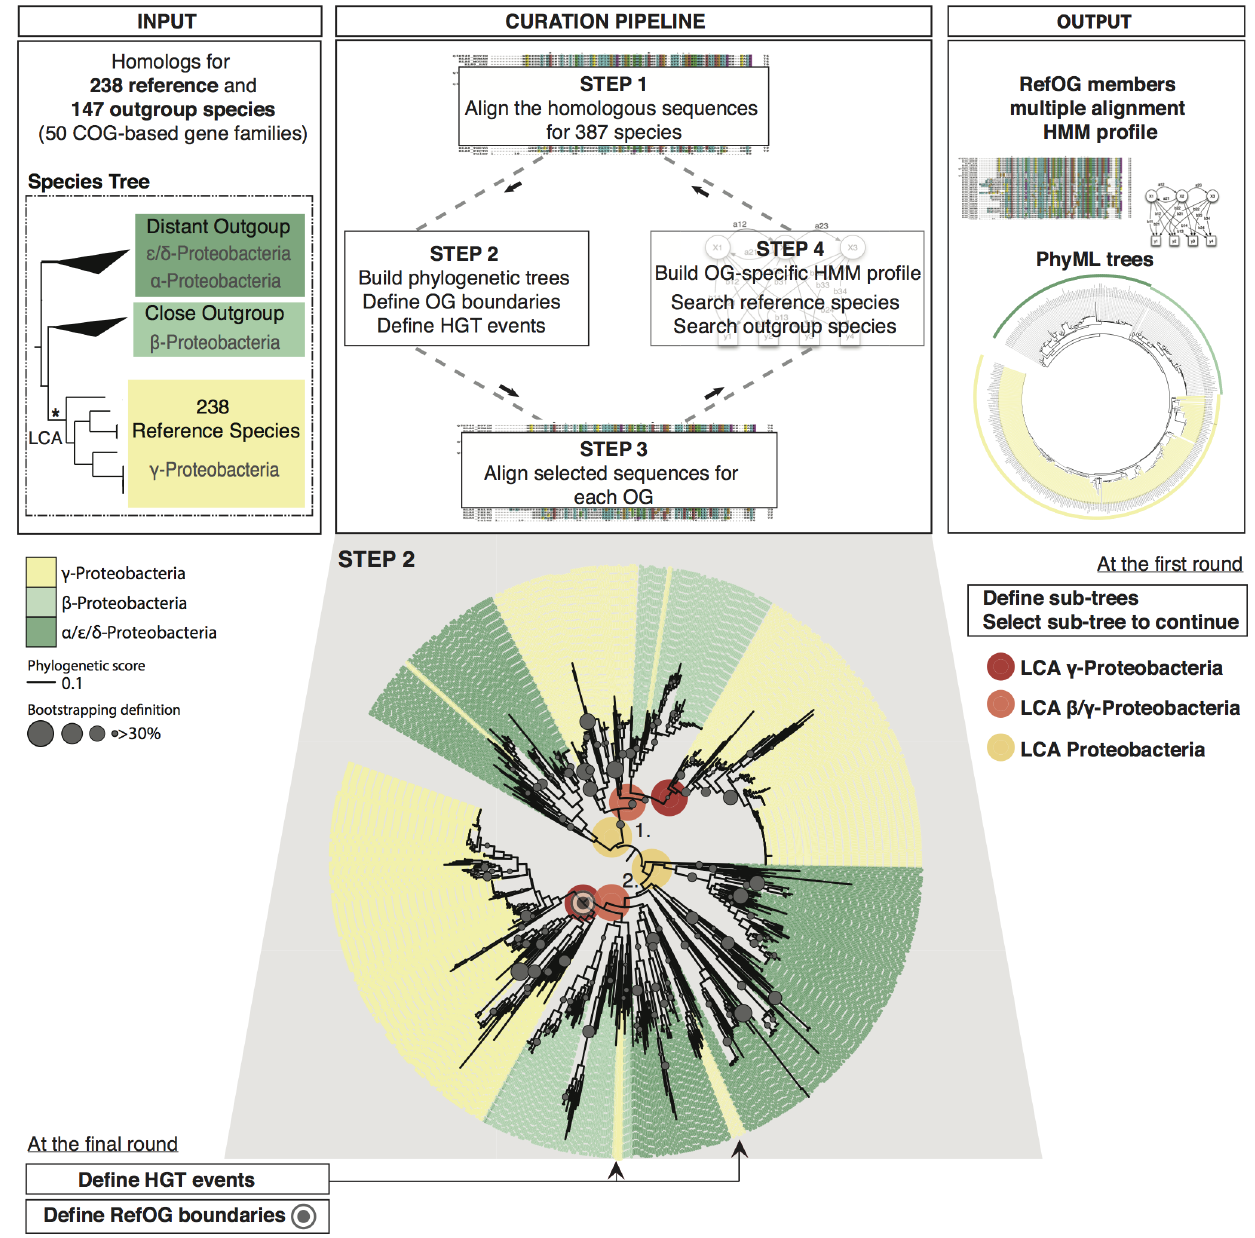
Figure 1. Flowchart for generating reference orthologous groups. The initial material (INPUT) is the homologs in 385 bacterial species for 50 error-prone families (Table S1 in Data S1). The homologs were chosen from the Clusters of Orthologous Groups (COGs), as these are inferred in the eggNOG database [10]. Depending on the complexity of the gene family, we performed two (ancient, well-conserved families) up to five (genus- specific, highly versatile families) rounds of curation. We followed four distinct steps at every round. The homologous (or later orthologous) sequences were aligned (Step 1) and the multiple sequence alignments (MSA) were used to build phylogenetic trees (Step 2). Each family tree was compared to a well-accepted species tree [32]. At the first round, species topology was used to define the boundaries of gene sub-families (sub-tress that include sequences from all three clades: a -, b - and c - Proteobacteria), while at the following rounds, bona-fide orthologous groups related to the LCA of c - Proteobacteria. The protein sequences of the members of each orthologous groups were re-aligned (Step 3). The new alignments were used to build Hidden Markov Models (HMMs), search the 385 bacterial genomes and define new homologs (Step 4). At the final round, we finalized the reference orthologous groups (OUTPUT) and identified and annotated through manual inspection HGT events and